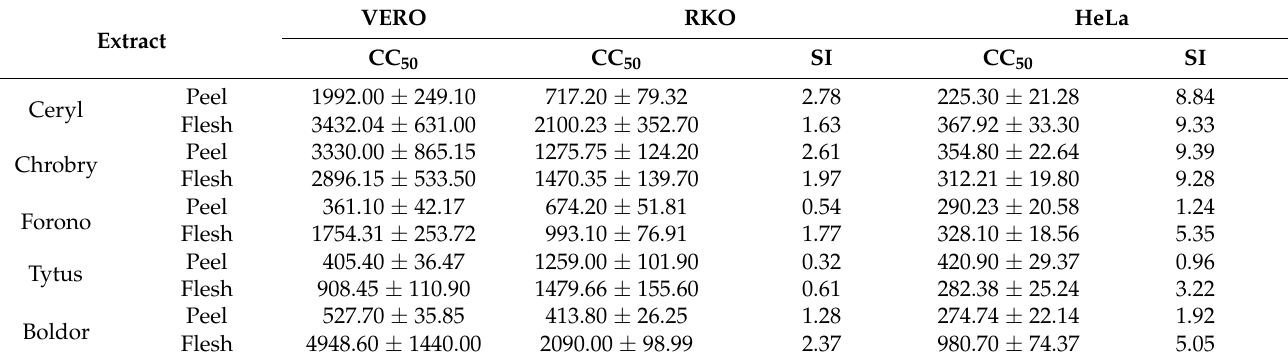
Table 7. Cytotoxicity and anticancer selectivity of B. vulgaris extracts on different cell lines after 24 h